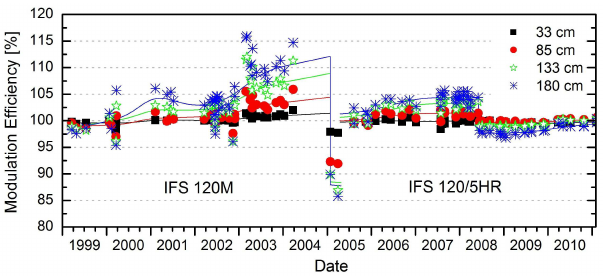
Fig. 5. Times series of the modulation efficiency [%] at different op- tical path differences (OPD) for the Iza˜na spectrometers. Individual data points indicate individual cell measurements. The lines are the smoothed efficiency curves used during the FTIR retrievals. Black at 38cm, red at 85cm, green at 133cm and blue at